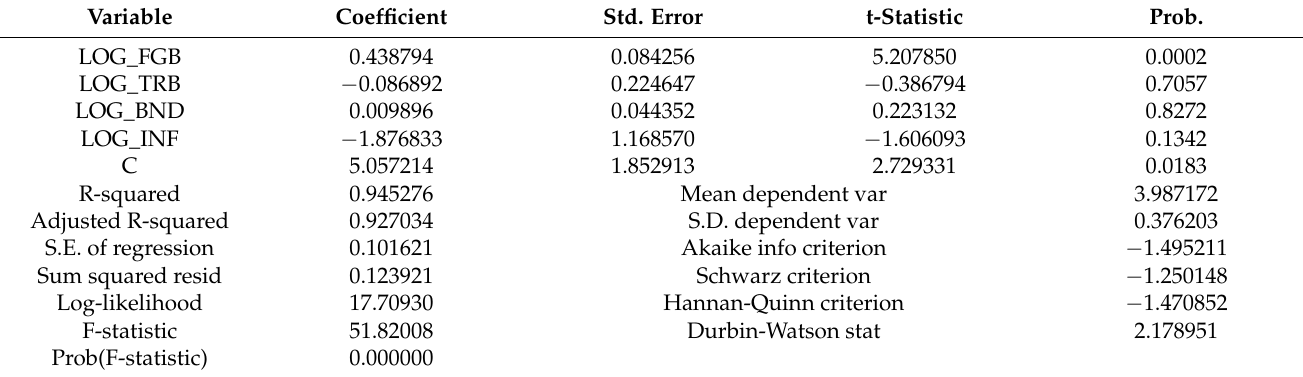
Table 5. Regression result. Method: Least Squares. Sample: 2003–2019. Included observations: